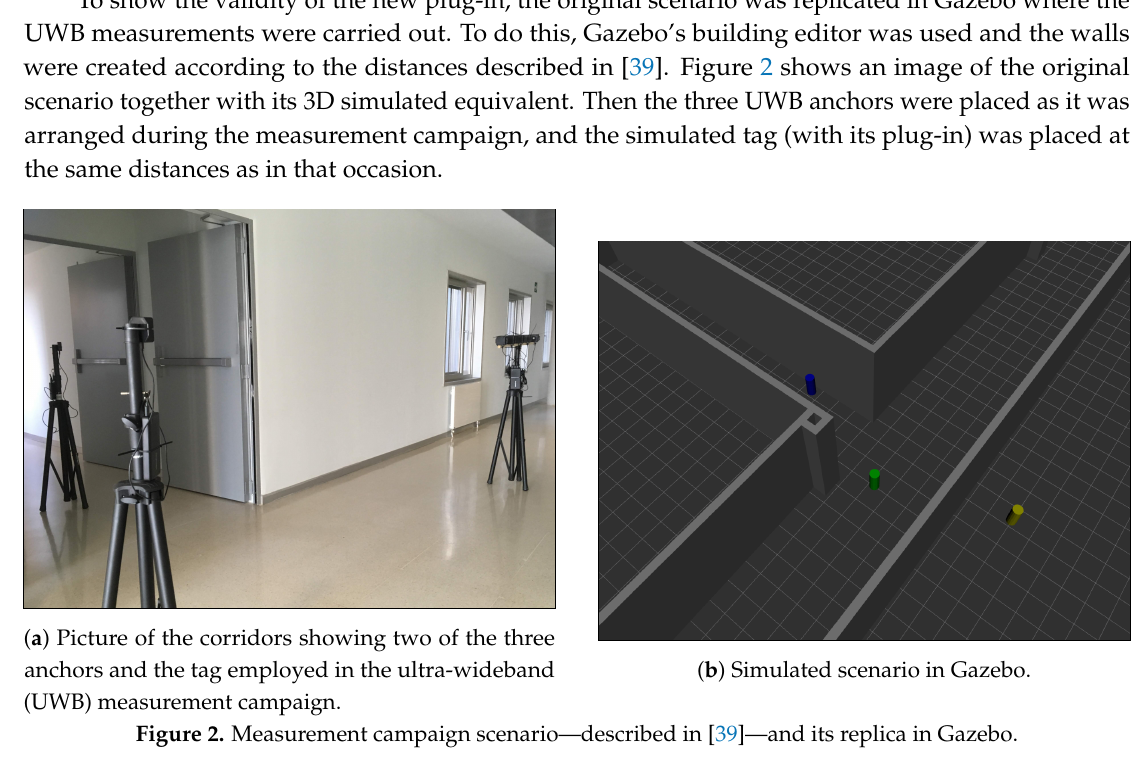
Figure 1. The color of the anchors indicates their state: green—line-of-sight (LOS), yellow—non- line-of-sight (NLOS) soft, blue—NLOS hard, and red—out of range. Simulation Accuracy